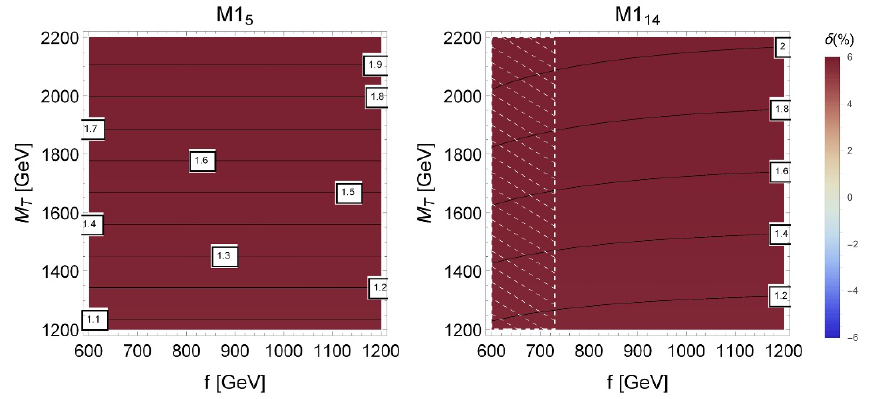
Figure 16 . The contour plots of (cid:14) ( p cut ) with sin 2 (cid:18) L = 0 : 025 and p cut = 600 GeV for the singlet T T models with one top partner multiplet. The corresponding values of y are indicated by the solid lines. The region marked by dashed white lines indicates when (cid:20) t (cid:20) 0 :